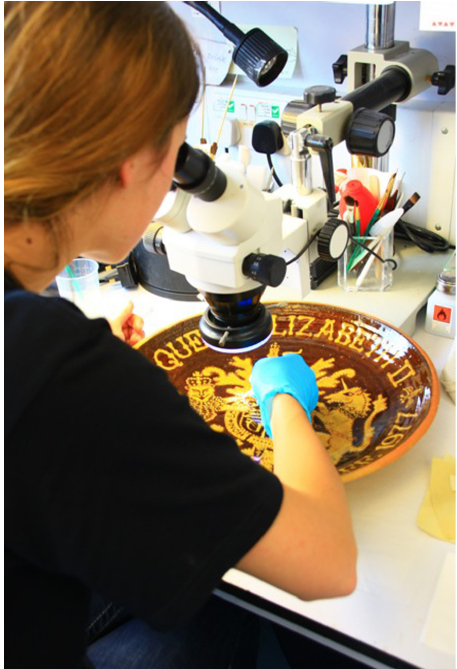
Fig. 2: A student at work in the Institute’s con- servation laboratories (photo: Lisa